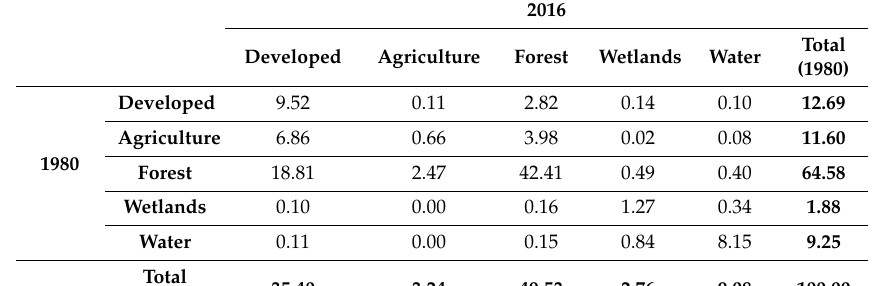
Table 6. Land Cover Change Matrix (in percent) for Coastal Pender County: 1980 – 2016. (Data source: NAIP).